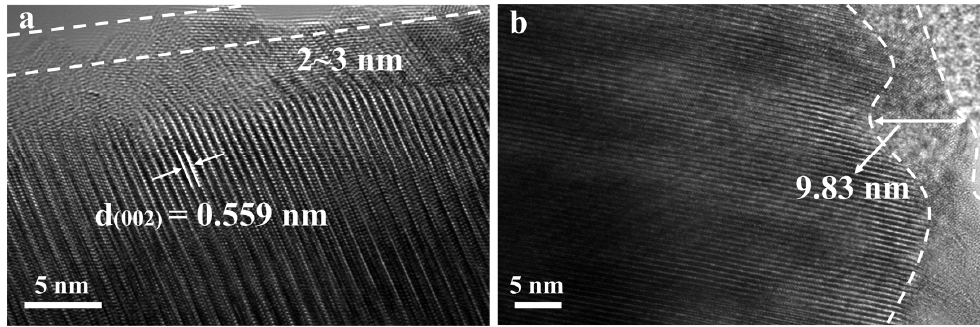
Figure 6. The HRTEM images of ( a ) P2-Na 0.67 MNNb and ( b ) P2-Na 0.67 MN after 500 cycles at 1 C and 25 °C in coin cells.